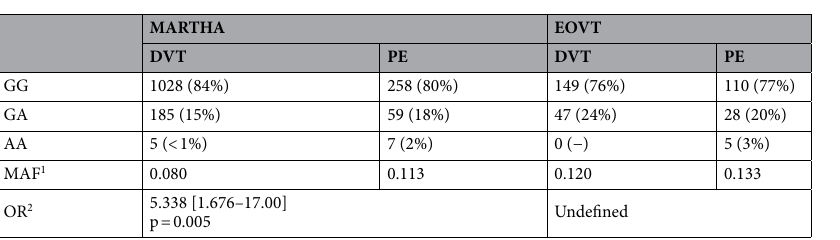
Table 3. Association of rs1424597 with PE risk in the MARTHA and EOVT studies. MAF Minor Allele Frequency. OR: Allelic Odds Ratio [95% CI] adjusted for sex and age at DVT/PE event, under the assumption of recessive